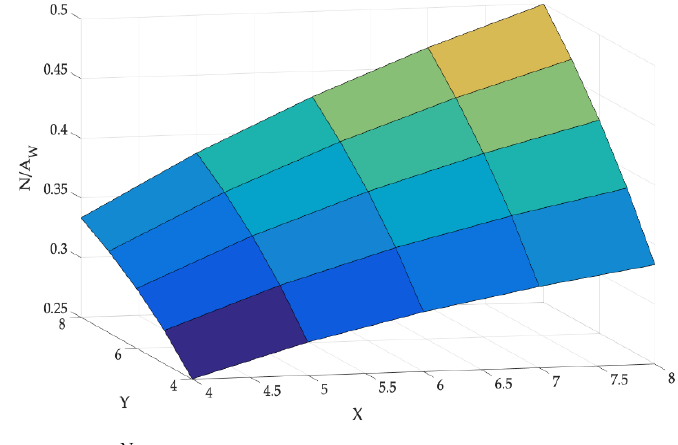
N as a function of X and Y (room Figure 5. 𝑁 as a function of X and Y (room dimensions). Figure 5. A W 𝐴 𝑊